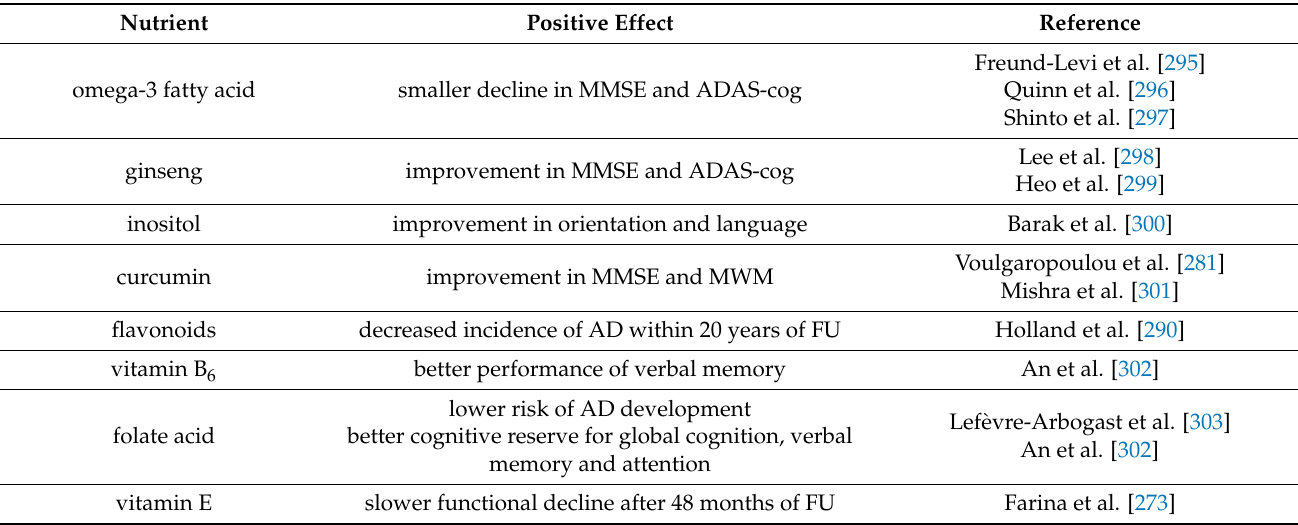
Table 1. Positive effects of various nutrients on